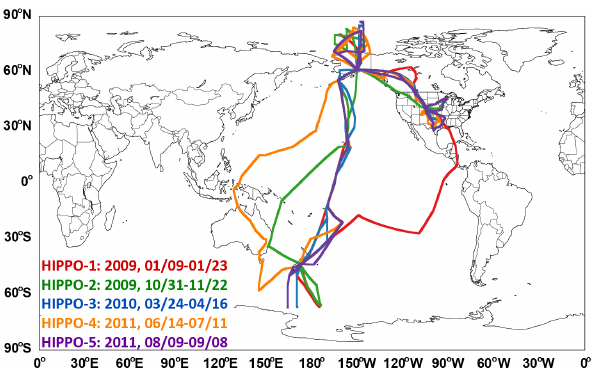
Figure 1. Times and flight tracks of five HIPPO campaigns. Our analysis is focused on CO over the Pacific